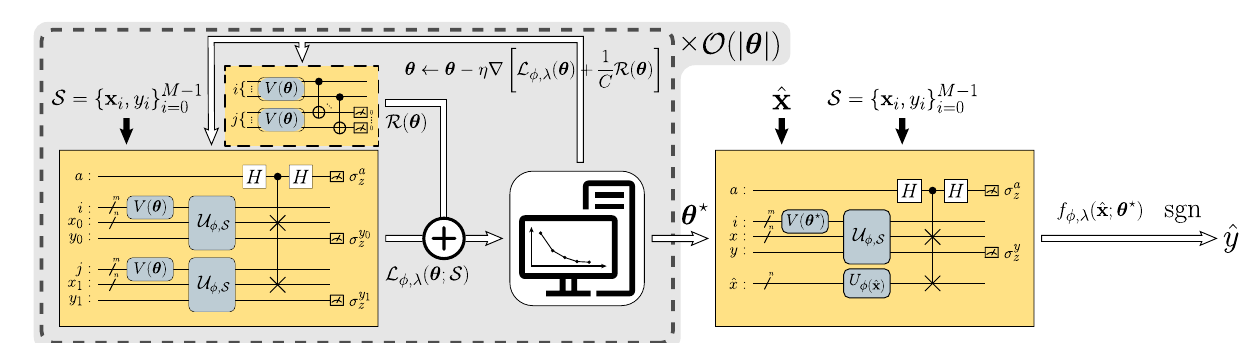
Figure 1. Circuit architecture of VQASVM. Loss, decision, and regularization circuits are shown in the order of panel ( a , b ), and ( c ) all qubits of index registers i and j are initialized to 0 . Ansatz V ( θ ) is a PQC of m | � set S with a quantum feature map U φ( number of qubits for the quantum feature map, which is usually N , but can be reduced to log ( N ) if an amplitude encoding feature map is used.